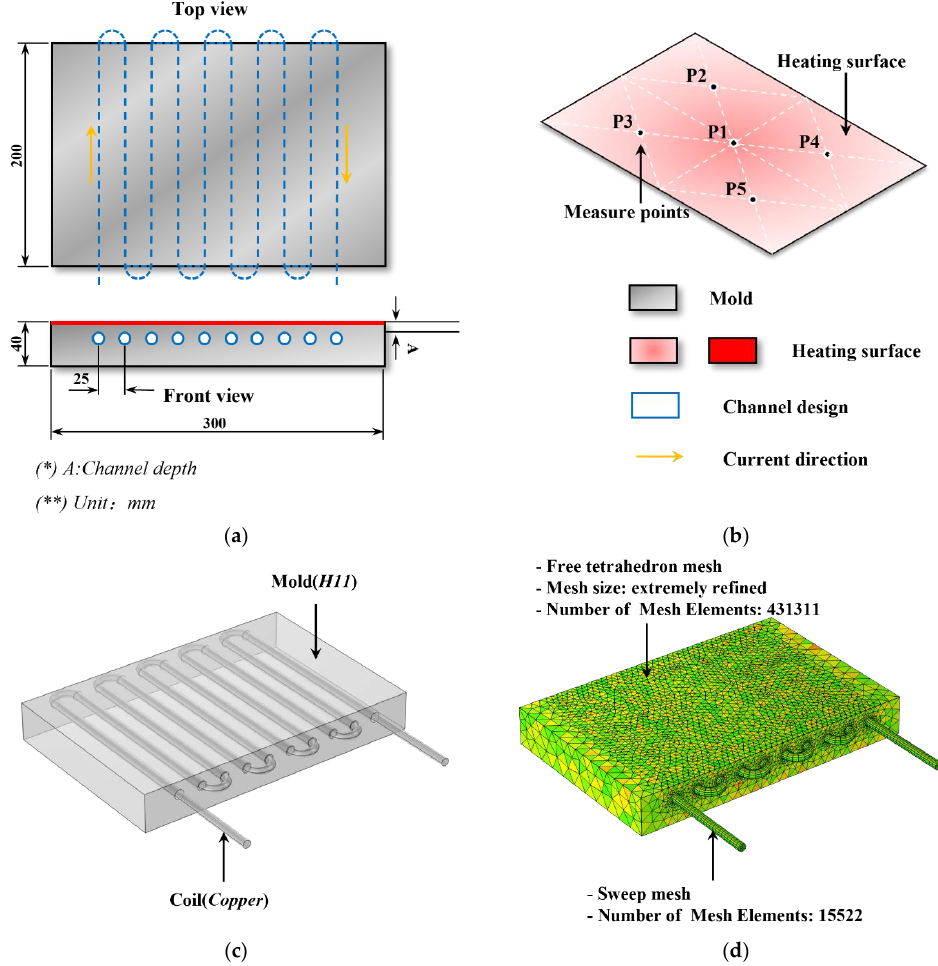
Figure 1. Mold model drawing and temperature measure points: ( a ) mold size drawing; ( b ) temperature measure points; ( c ) mold 3D model drawing; ( d ) mesh division drawing. The temperature of 5 measuring points on the mold surface, as shown in Figure 1(b), was selected as the final result and the reference temperature of the mold surface. After heating for 30 s, the final temperature at these 5 points was obtained, and their mean tem- perature was calculated using Equation (9) and regarded as the final heating temperature of the mold. Figure 1(c) shows a perspective view of the 3D simulation model with the induction coil interspersed in the interior of the mold, and Figure 1(d) shows the mesh division. The focus of this simulation was to characterize the temperature distribution on the surface of the mold, therefore a very fine free tetrahedral mesh was used for the mold and, for the coil, a swept mesh with 15522 mesh elements was used, which reduces the